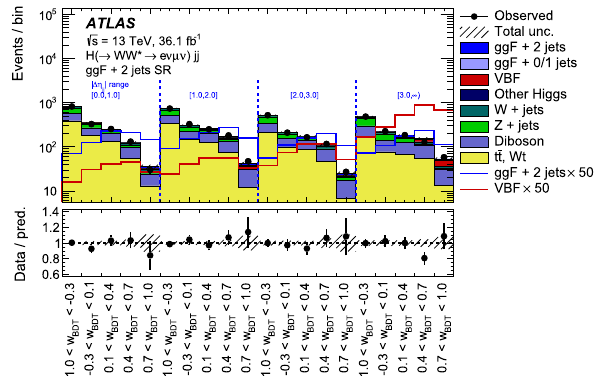
Fig. 3 Post-fit distribution of the BDT response observable presented in the four | (cid:10)η jj | categories of the ggF + 2 jets signal region, with signal and background yields fixed from the fit for μ ggF + 2jets . Data-to- simulation ratios are shown at the bottom of the plot. The shaded areas depictthetotaluncertainty.ThedistributionsoftheggF +2jetsandVBF processes are overlaid with their respective contributions multiplied by 50